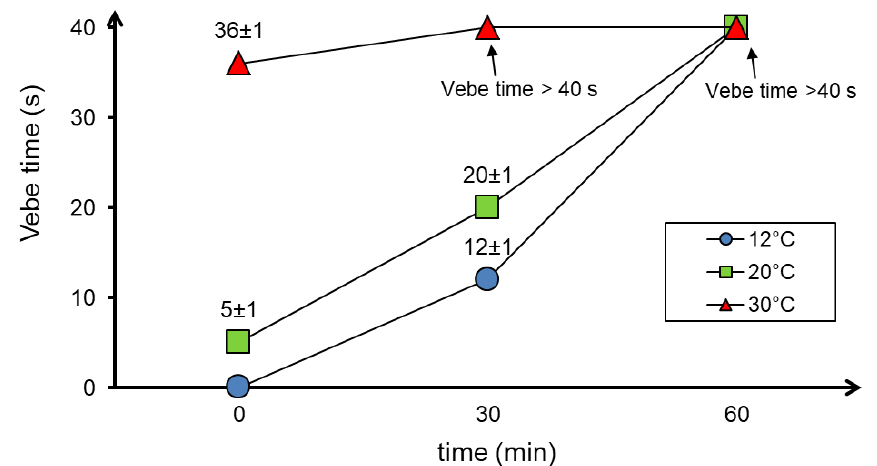
Figure 5. Results of concrete mixture consistency tests with the use of the Vebe test depending on the temperature and time of testing.